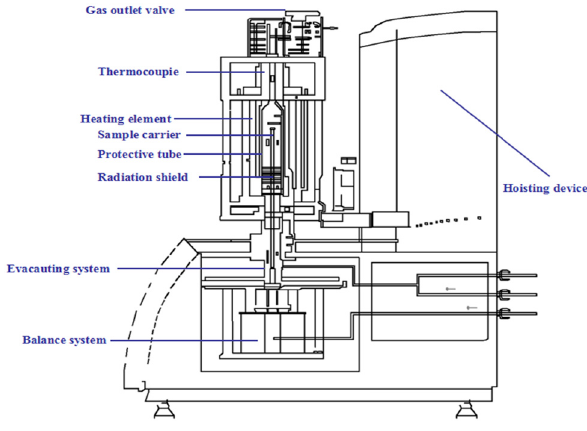
Figure 1: Schematic of experimental equipment.